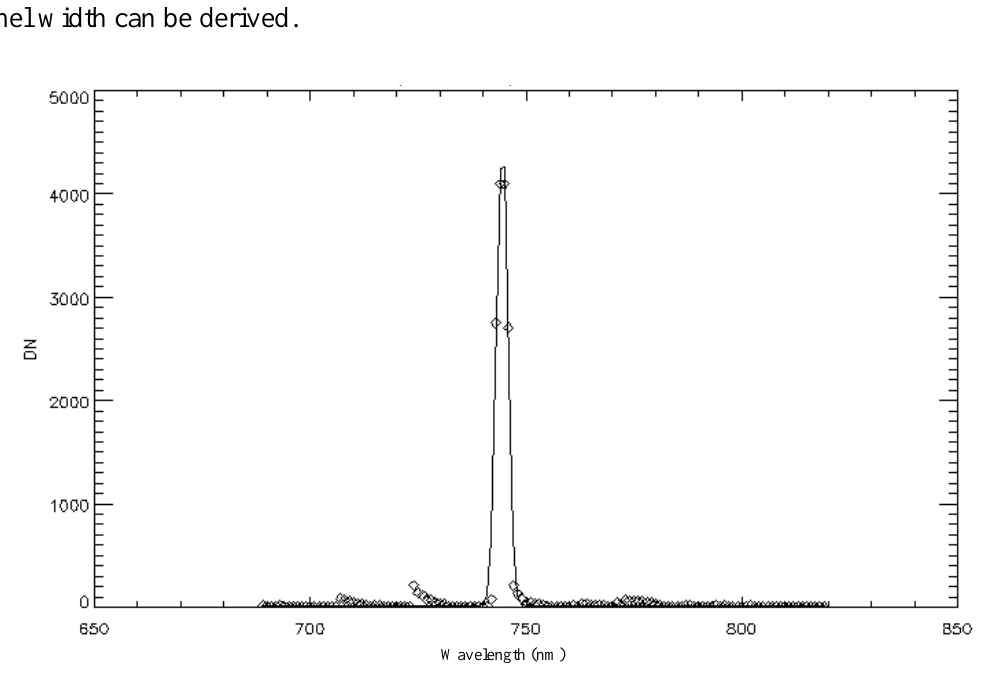
Figure 7. The center wavelength of each channel and linear fitting results: black squares are the actual center wavelengths obtained by calculating A and the red line is the linear fitting